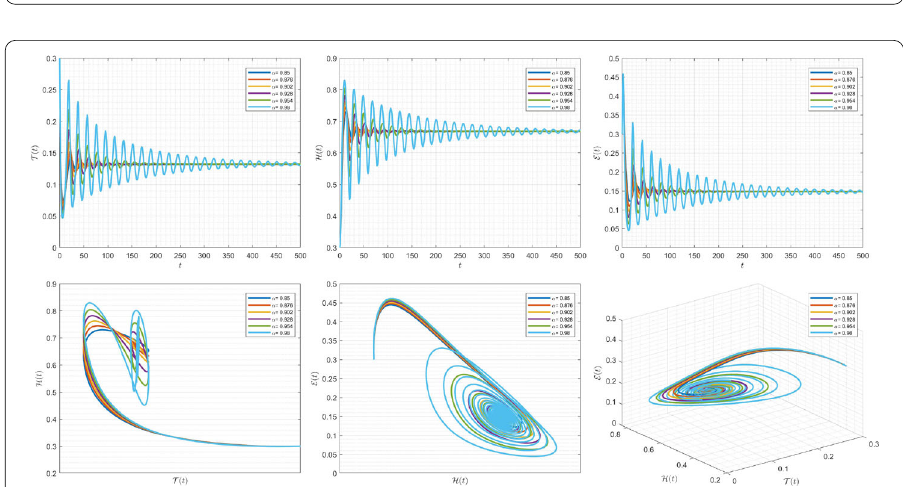
Figure 7 Simulations for solving (43) using (59) along with ( T (0), H (0), E (0)) = (0.1,0.1,0.1)